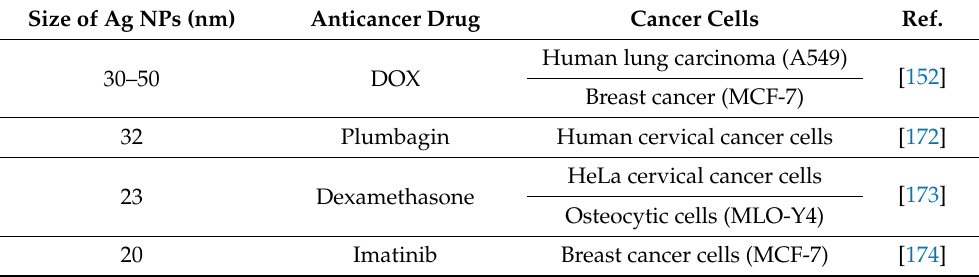
Table 3. Examples of Ag NPs as